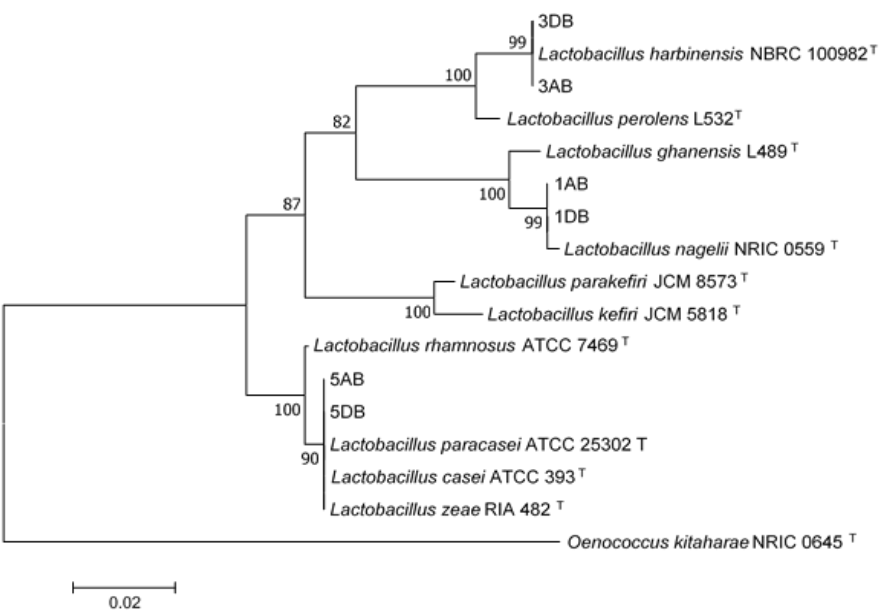
Figure 6. Phylogenetic tree based on the partial sequence of the 16S rRNA gene of Lactobacillus spp. isolates. The tree was constructed using the neighbor-joining method. Bootstrap values (1000 tree interactions) are indicated at the nodes. T- means type strain.